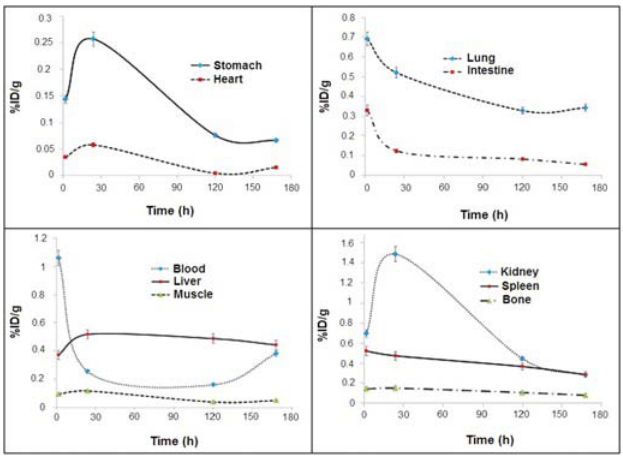
FIGURE 10 - The clearance curves from each organ of the rats. TABLE Π - Absorbed dose in each organ of human after injection